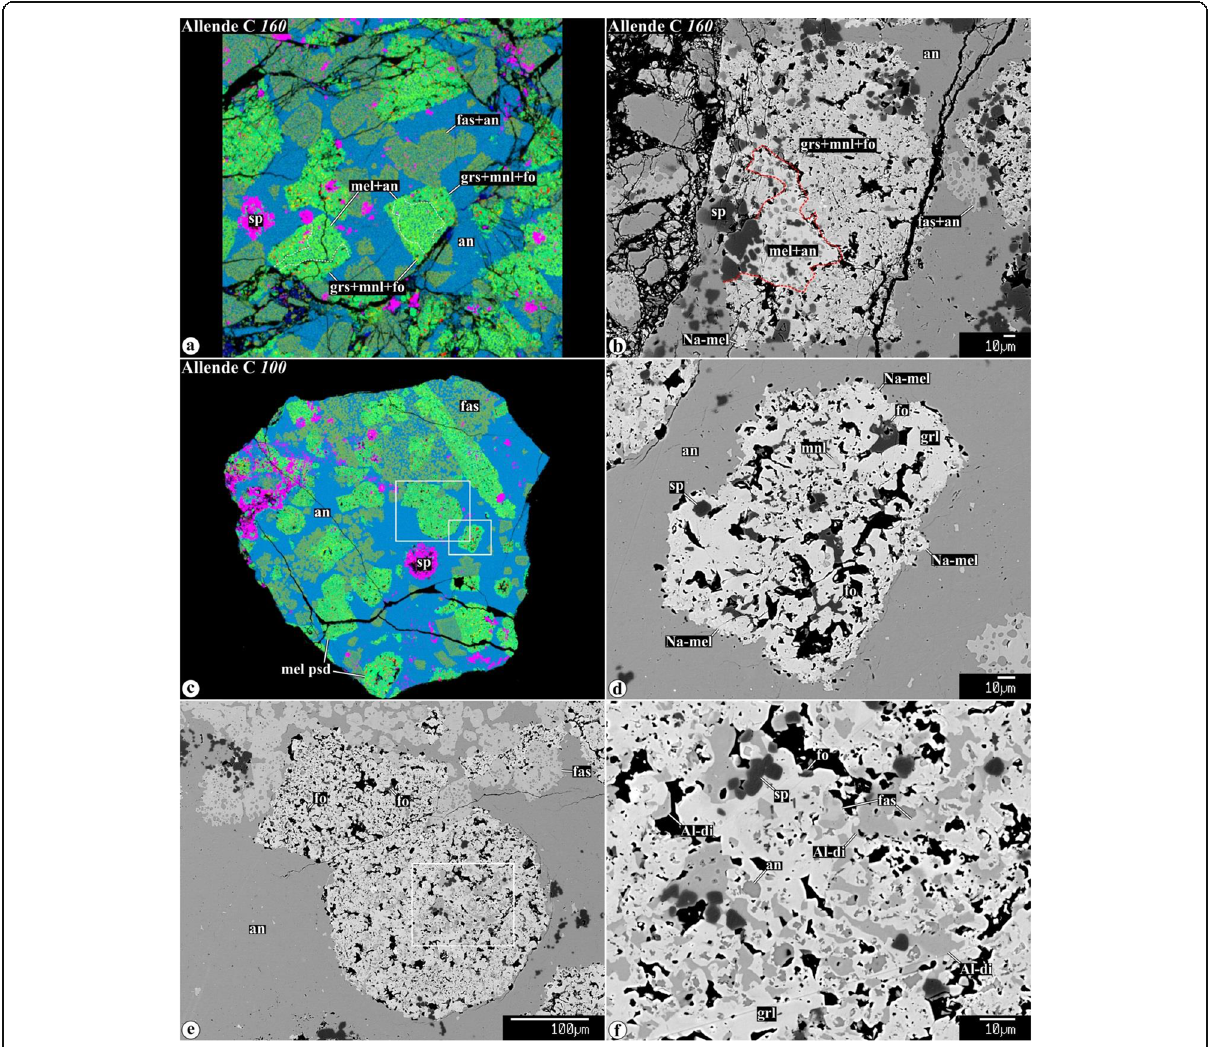
Fig. 8 a , c Combined x-ray elemental maps in Mg (red), Ca (green), and Al (blue), and ( b , d − f ) backscattered electron images of the interior regions of Type C CAIs ( a , b ) 160 and ( c − f ) 100. Regions outlined in c and e are shown in detail in d – f , respectively. Lacy melilite composed of åkermanitic melilite with numerous rounded inclusions of anorthite is pseudomorphically replaced to various degrees by grossular-forsterite- monticellite and grossular-Al-diopside. Anorthite groundmass around melilite pseudomorphs shows little evidence for alteration: small amount